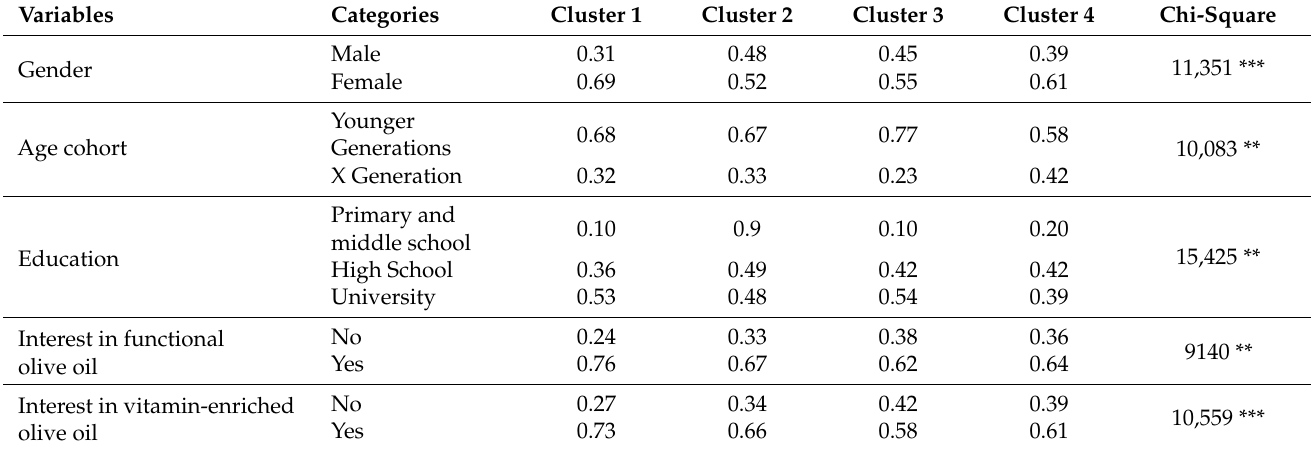
Table 5. Socio-demographic characteristics of clusters and interest in functional extra virgin olive